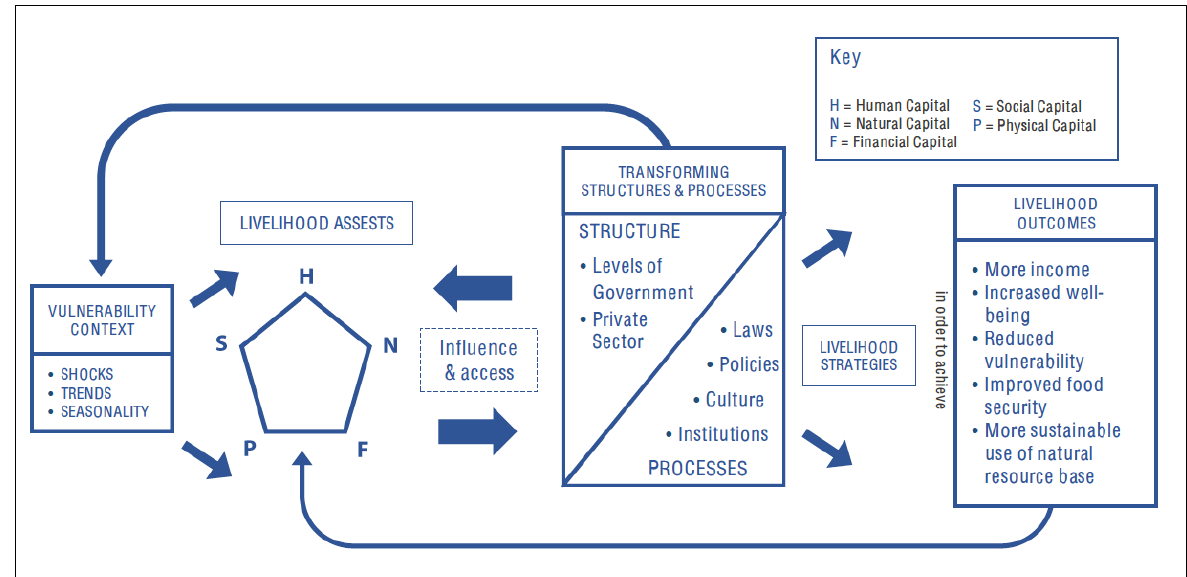
Figure 1. The Sustainable Livelihood Analysis (SLA) Framework, Adapted from the Department for International